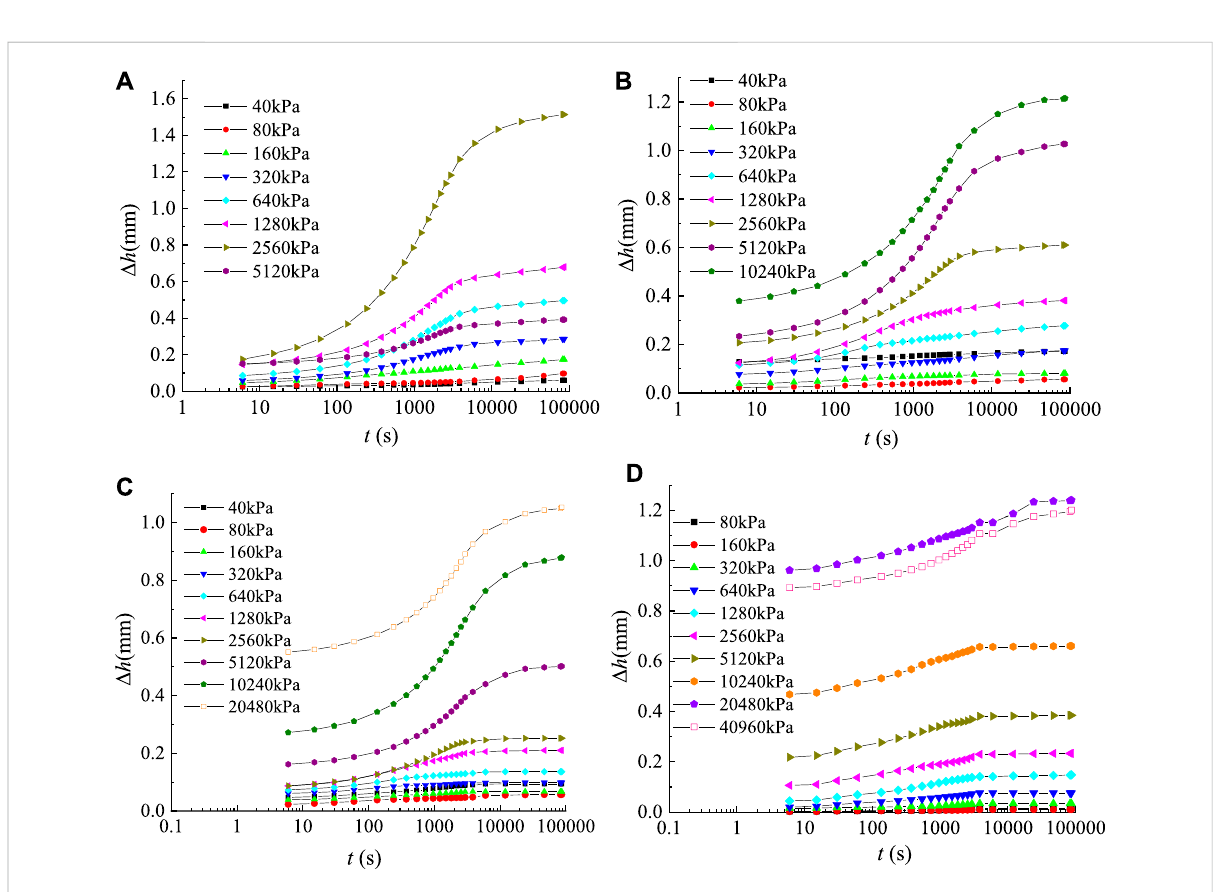
FIGURE 2 Time-varyingdeformationcurvesofsoilsamplesunderdifferentloadswithsamplingdepthsof52.3 m (A) ,145.5 m (B) ,292.3 m (C) and395.1 m (D) ,